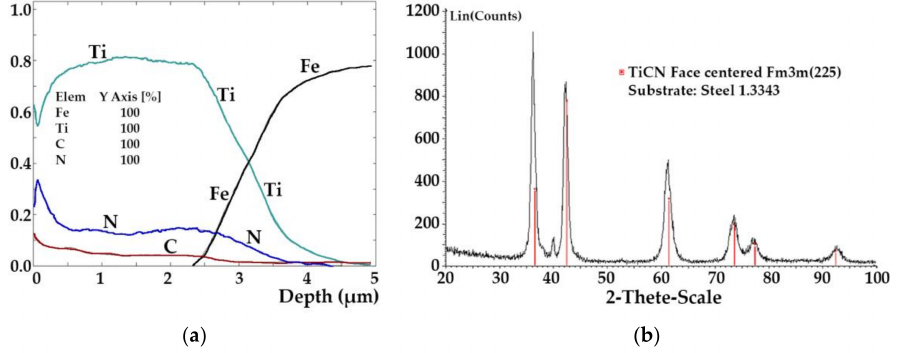
Figure 6. An analysis of the TiCN-MP coating deposited on substrate 1.3343 with 61 HRC: ( a ) GD-OES analysis; ( b ) GI qualitative X-ray analysis.